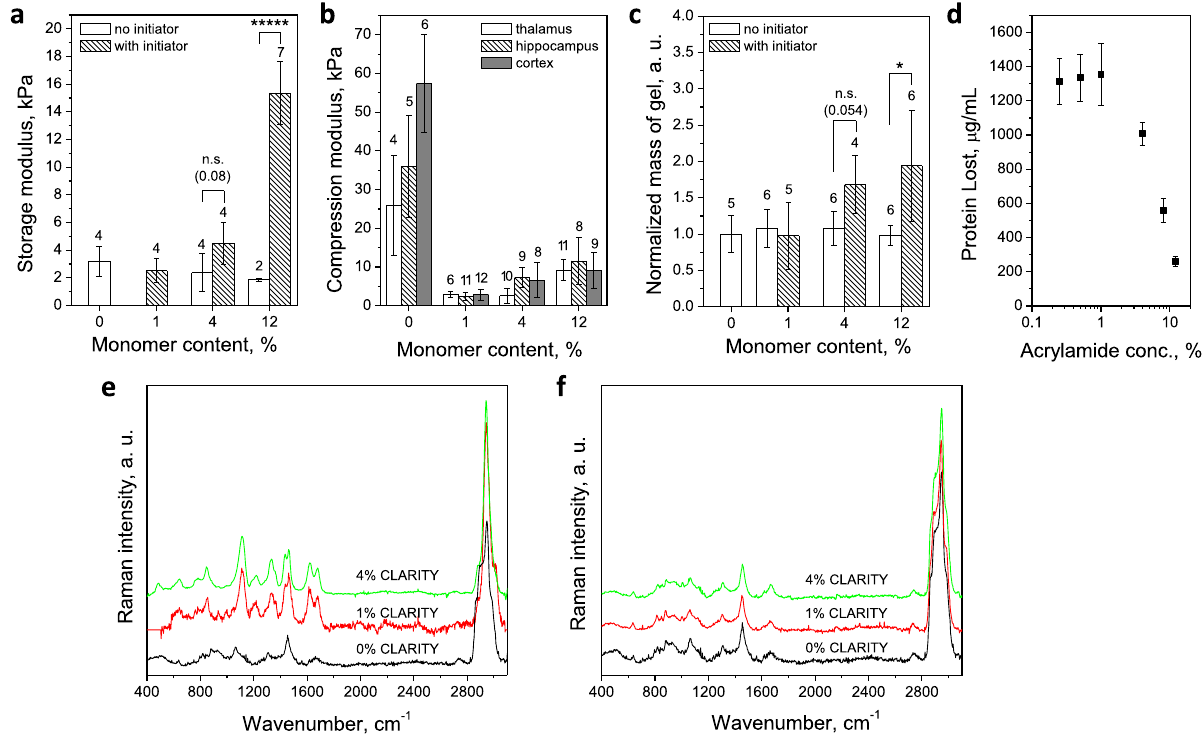
Figure 2. Effect of initiator and different monomer concentrations on rheology and chemistry of CLARITY hybrids. ( a ) storage modulus averaged from 0.1 to 1 Hz and 26 C vs. monomer content, with initiator (hashed bars) and without (hollow bars), ( b ) compression modulus of thalamus (hollow bars), hippocampus (hashed bars) and cortex (filled bars) with increasing monomer content, ( c ) normalized to control sample mass of gel relative to monomer content, with initiator (hashed bars) and without (hollow bars), ( d ) protein loss measured as protein concentration (μg ml −1 ) in 4% SDS surfactant solution rinsate after 14 days of washing at 37 C as a function of increasing % AAm (n = 8 across 4 animals), ( e ) Raman spectra of cleared brain tissue prepared with 0, 1 and 4% AAm and initiator, ( f ) Raman spectra of cleared brain tissue prepared with 0, 1 and 4% AAm and no initiator. For a , b , c number of samples marked on top of each bar. Error bars mark means SD. Statistical significance marked as follows: *(p < 0.05), *****(p < 0.00001), as measured by 2 sided non parametric Mann Whitney U